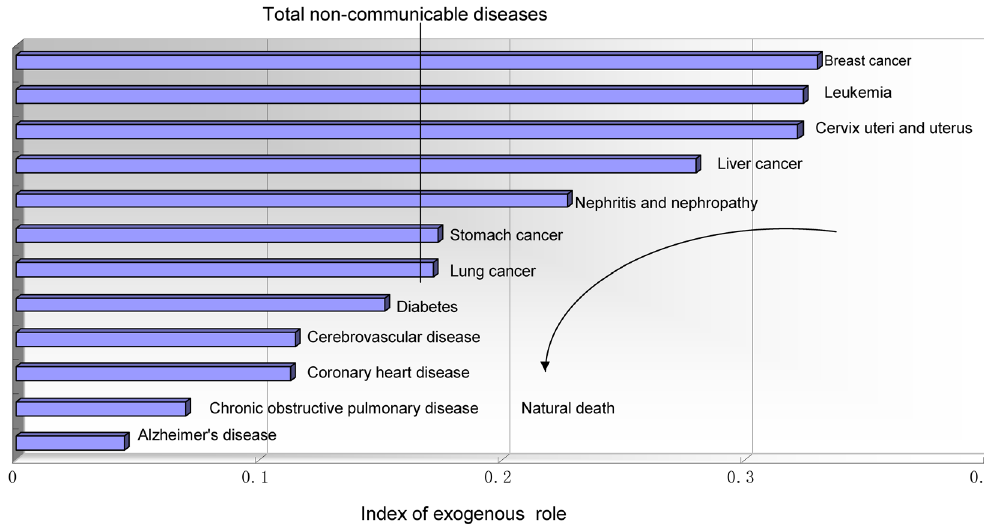
Figure 3. A tendency of natural death with weaker exogenous role in the diseases resulting in